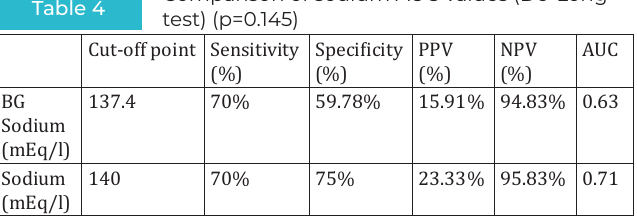
Comparison of sodium AUC values (De-Long test) (p=0.145)